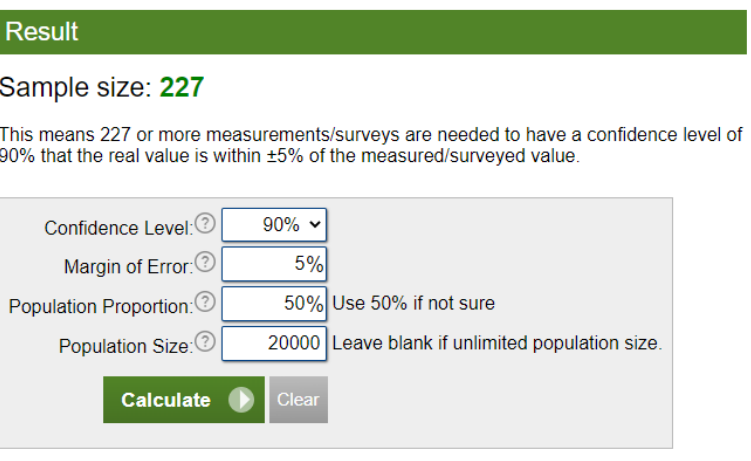
Figure 4. Sample Size Calculator. (https://www.calculator.net/sample-size-calculator.html?type=1&